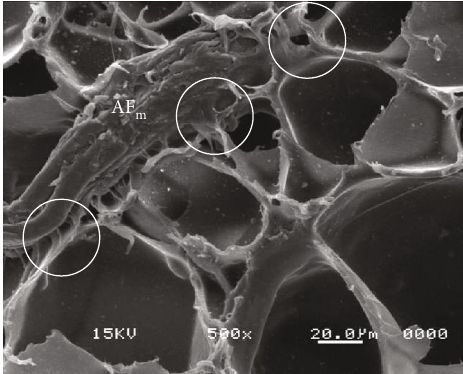
Figure 5: SEM micrograph for a AF foam with 15 wt-% of Agave fi ber, interacting with LDPE/EVA blend foamed.